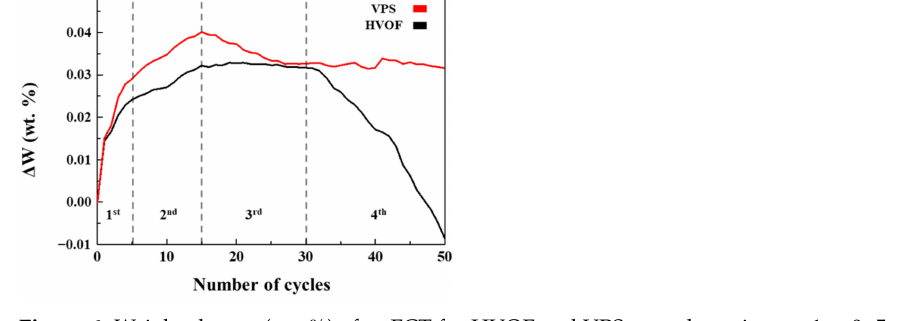
Figure 6. Weight change (wt. %) after FCT for HVOF and VPS coated specimens; 1st: 0~5 cycles, 2nd: 5~15 cycles, 3rd: 15~30 cycles, 4th: 30~50 cycles.